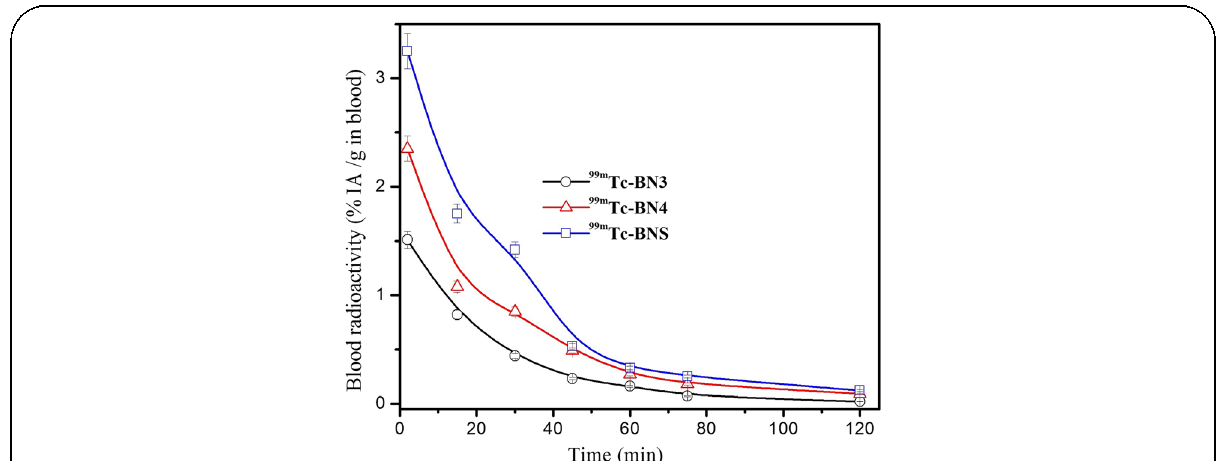
Fig. 6 Blood clearance – time profile of radiolabeled peptides (mentioned inside the figure). An average of five experiments ( N = 5) along with the mean ± SD have been